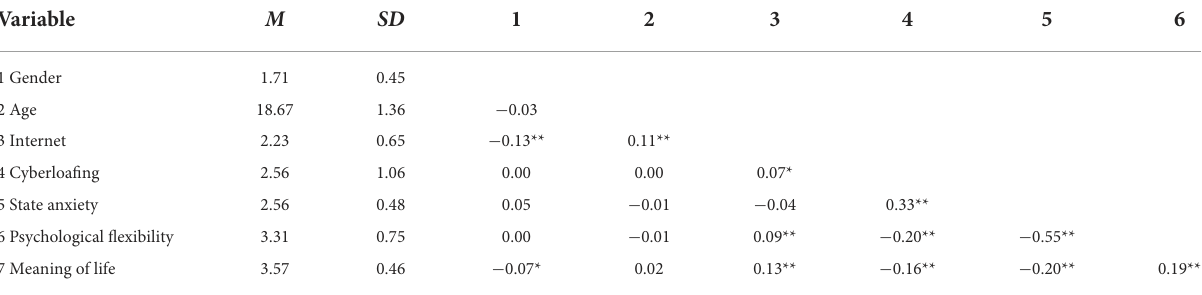
TABLE 2 Descriptive statistics and correlation